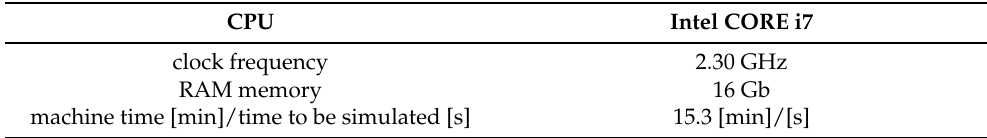
Table 3. Machine features and calculation